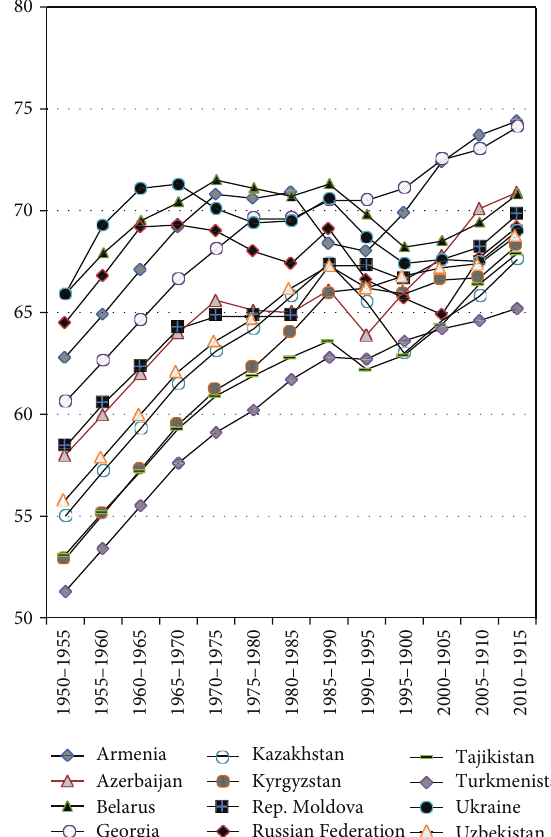
F 7: Life Expectancy at Birth in the CIS Countries, 1950 – 2015, medium variant (source: